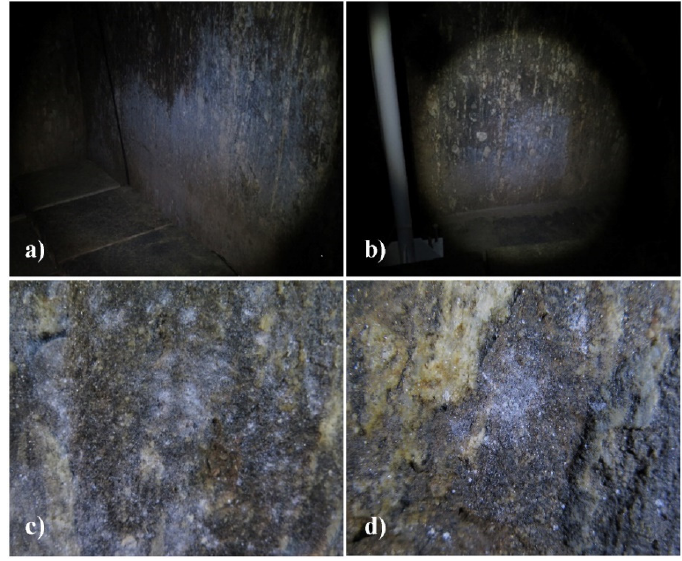
Figure 4. Biodeterioration patterns (whitish-grey patinas) on the wall in the main chamber of the Ancient Tombs in Neungsan-ri, Buyeo; ( a , c ) general view of the walls, ( b , d ) close view of biological patinas.